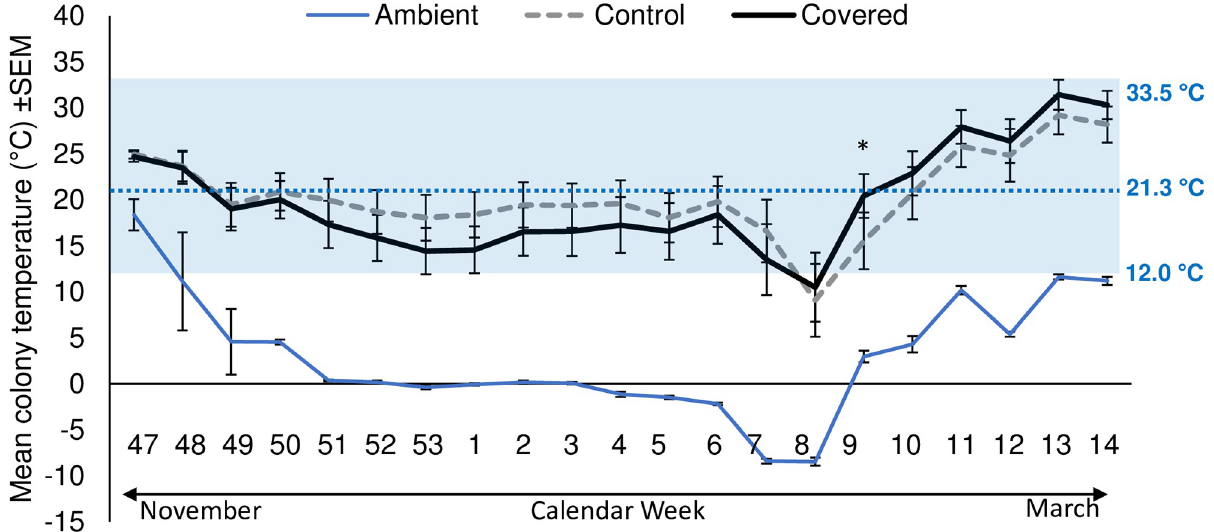
Fig 3. Average weekly temperature ( ± SEM) of colonies by treatment (control vs covered). Treatments were significantly warmer than the ambient temperature from within empty sentinel colonies, however, no difference in temperature was observed between covered and uncovered colonies. Throughout the winter colonies in both treatments were able to maintain cluster temperatures within the normal range for honey bee colonies (normal range 12–33.5˚C indicated by the shaded box and the blue dotted line indicates the average overwintering cluster temperature for healthy overwintering colonies;